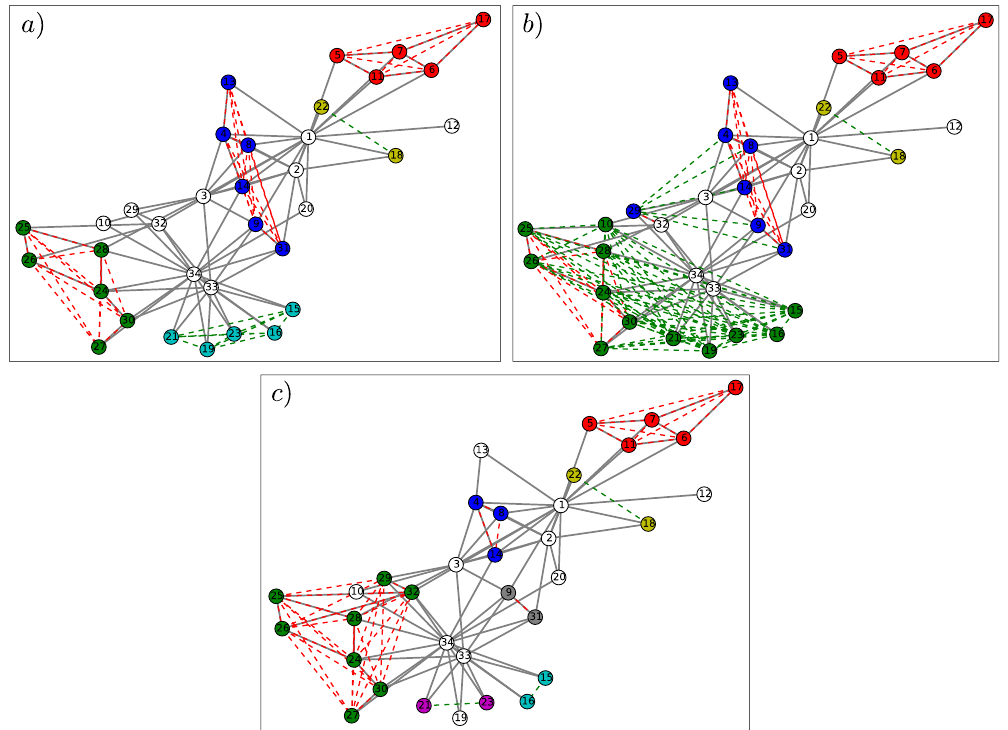
Figure 6. Synchronization patterns in the Karate club network for different values of parameters. The edges of the Karate club network are shown by solid grey connections. Remote and direct synchrony links with > . r 0 75 are shown by dashed green and red lines, respectively. Clusters of synchronized nodes are indicated by different colors of the full circles. For ω x = 0.7, δ = 0.2 π clusters of remote synchrony start to emerge (panel a). For larger values of the hubs’ natural frequencies ω x = 1, δ = 0.2 π , a large cluster of remotely synchronized nodes appears, as the leaf oscillators of hubs 33 and 34 become synchronized (panel b). Remote synchrony is hardly observed when δ = 0, ω x = 1 (panel